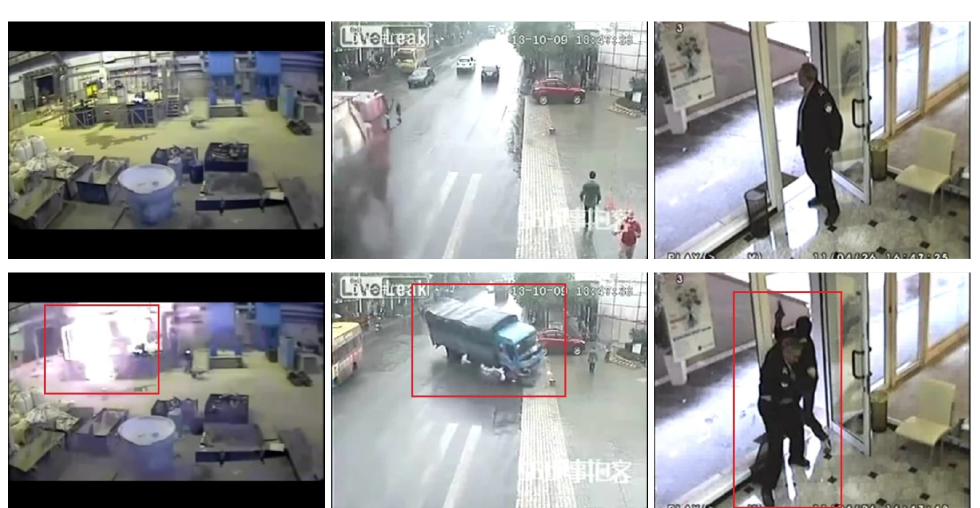
Figure 3. Examples of frames from the UCF-Crime dataset are presented. Normal frames are shown in the first row, and abnormal frames are in the second